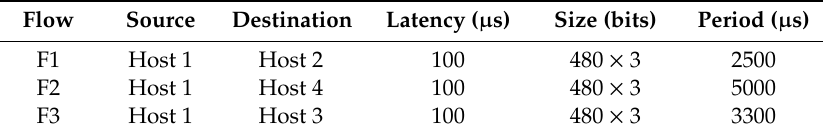
Table 1. The settings of the flows for the routing examples in Figure